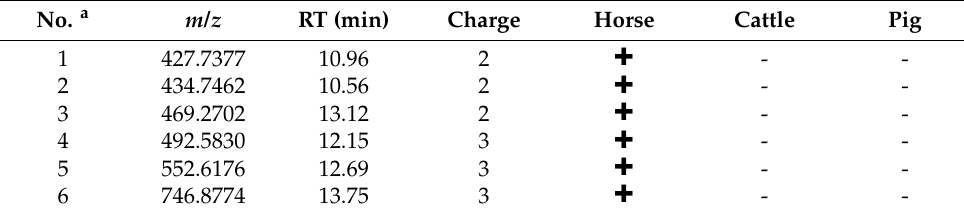
Table 1. The specific marker ions found in the peptide fragments produced from trypsin digestion of different animal skin gelatins by LC-Q-TOF-MS Table 3. Specificity evaluation of 6 markers found in authentic donkey sample by searching protein databases. All were also found in the authentic horse sample.